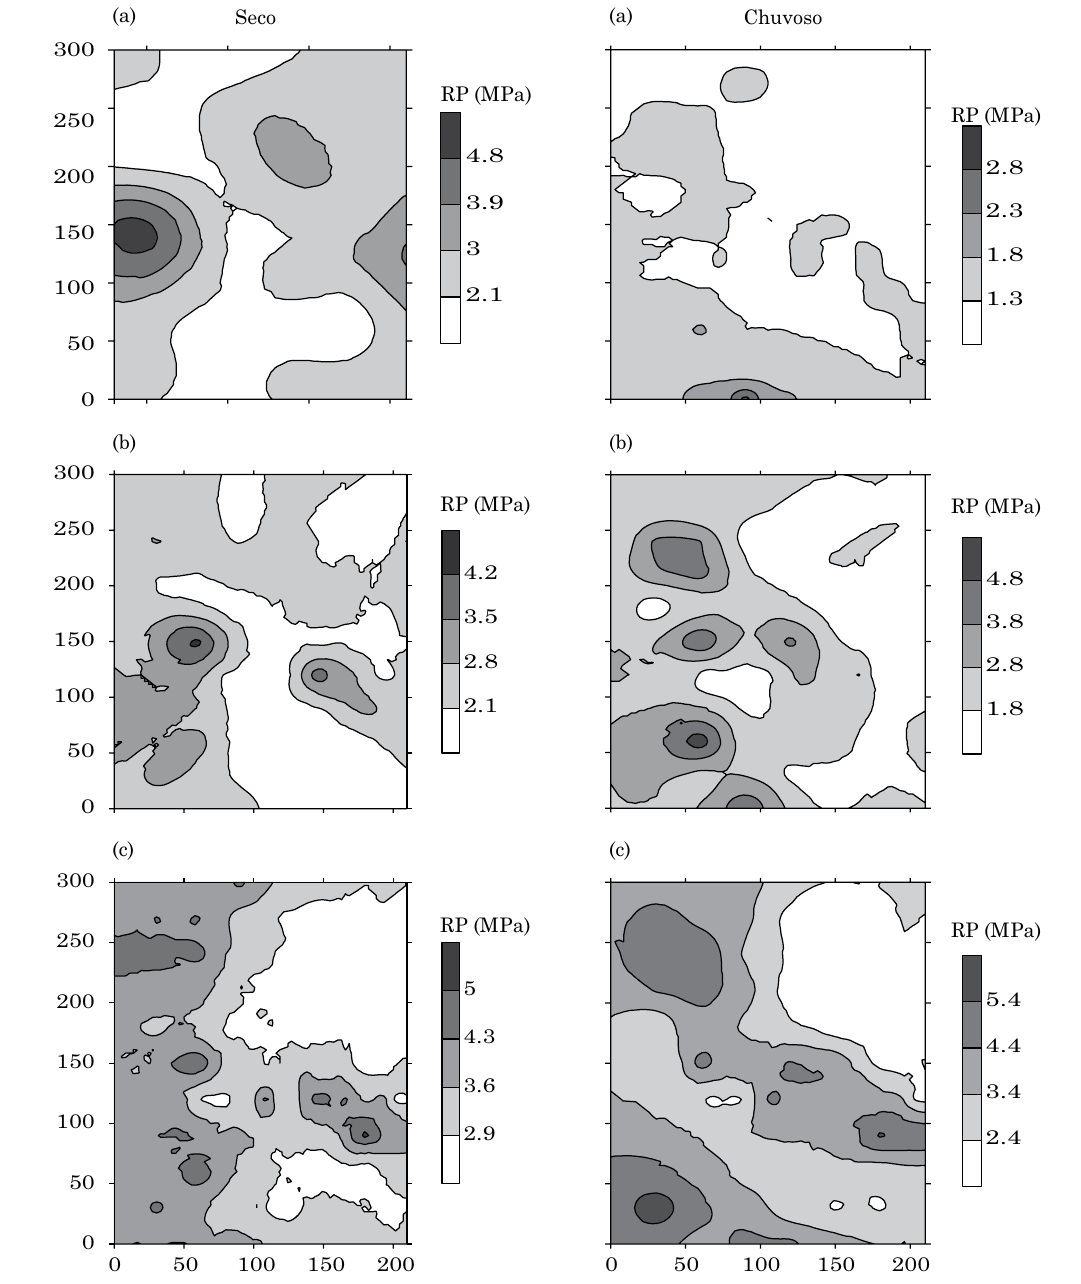
Figura 3. mapas da distribuição da resistência do solo à penetração (rp) nas profundidades de 0,00-0,10 m (a); 0,10-0,20 m (b) e 0,20-0,30 m (c), nos períodos seco e chuvoso, em área de Neossolo Litólico